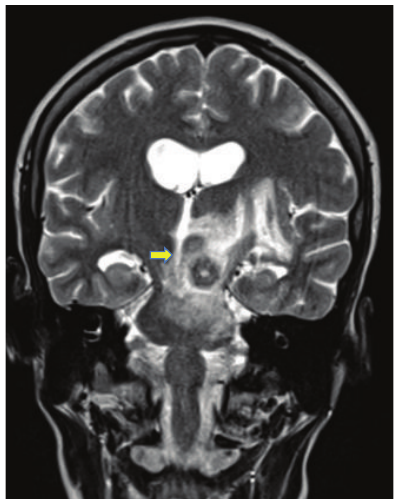
Figure 2: Tuberculoma in the left pedunculus cerebri at time of first encounter (horizontal view).